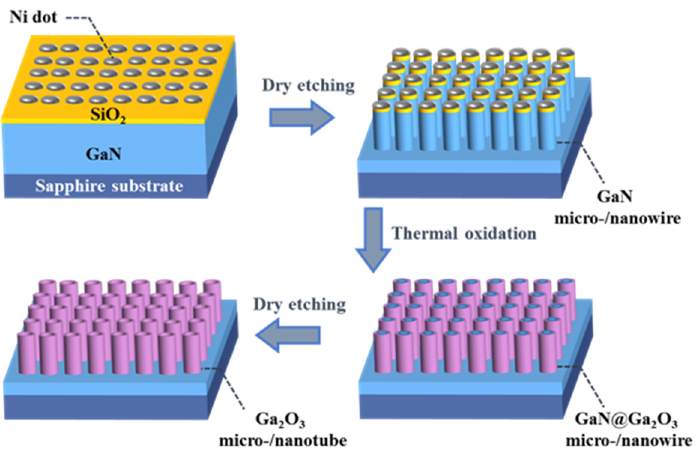
Figure 1. Schematic illustration for the synthesis β -Ga 2 O 3 micro/nanoarrays.